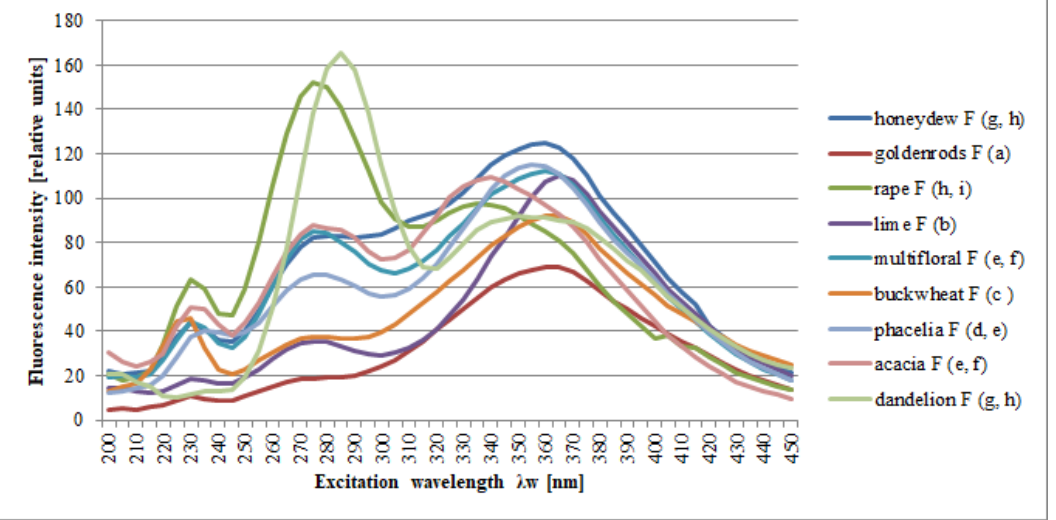
Figure 3. Normalized fluorescence emission spectra of different botanical origins of filtered honeys; the letters ( a – i ) indicate homogeneous groups, separated as a result of post-hoc analysis (Duncan’s test). Source: own research.